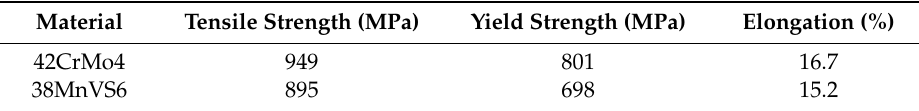
Table 2. Mechanical properties of 42CrMo and